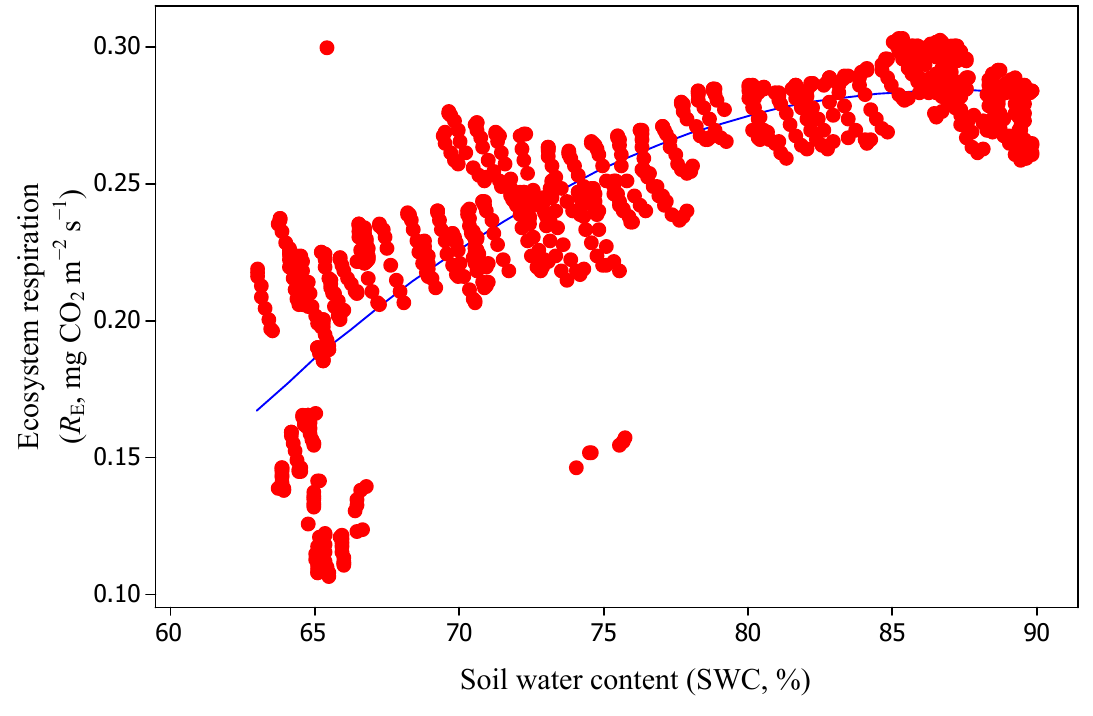
Figure 13. A comparison of SWC versus daytime R Yenicaga peatland ( R 2 = 68.7%; SE = 0.025; n = 896; P < adj